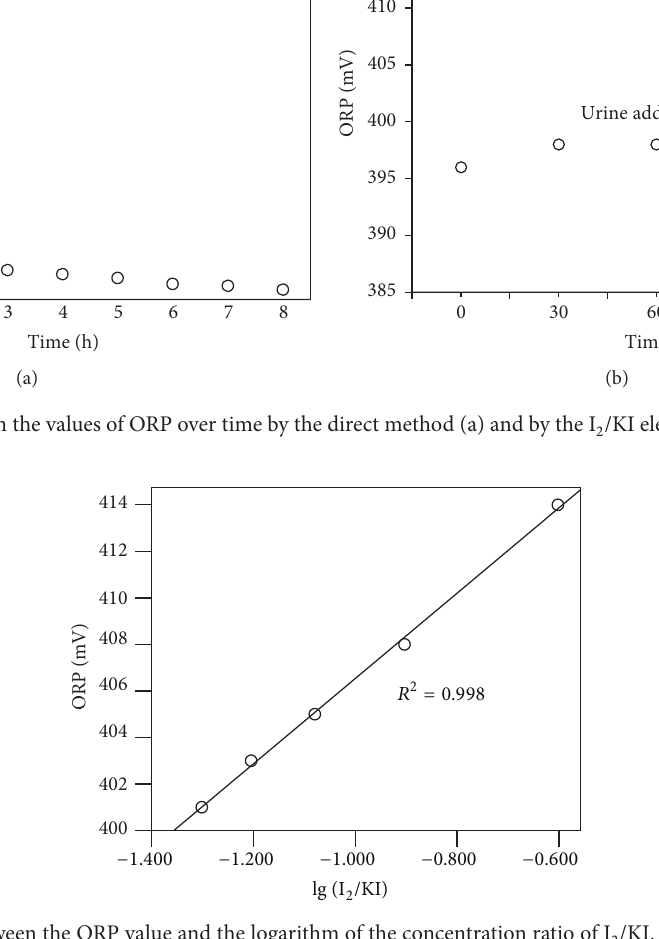
Figure 2: Liner relationship between the ORP value and the logarithm of the concentration ratio of I 2 /KI. (The ratios of I 2 /KI are 1:4, 1:8, 1: 12, 1: 16, and 1: 20, resp.).